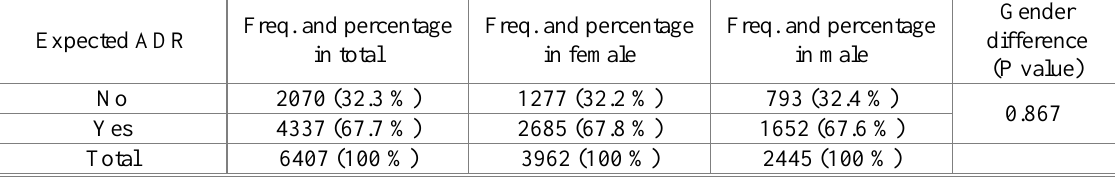
Table 9: Expectedness of ADR for each gender Freq. and Expected ADR